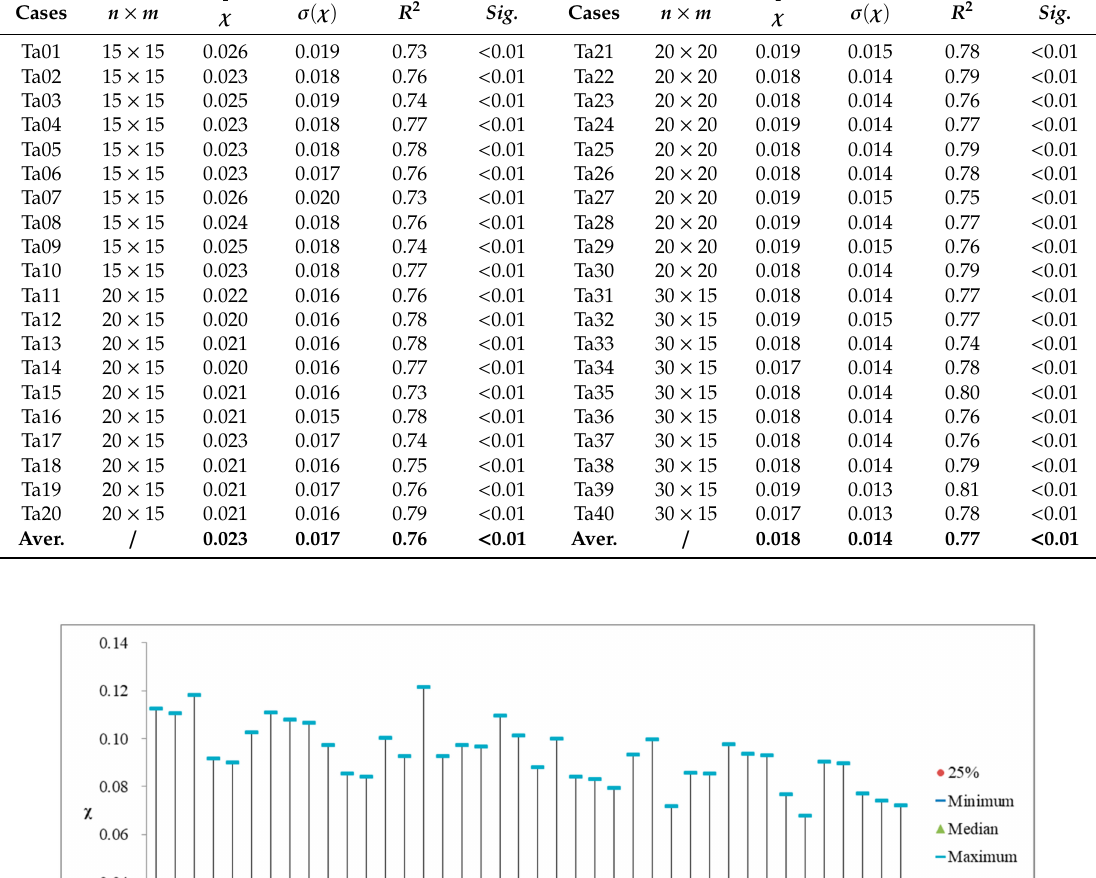
Table 2. The experimental results of the meta-model in the problem set TA.